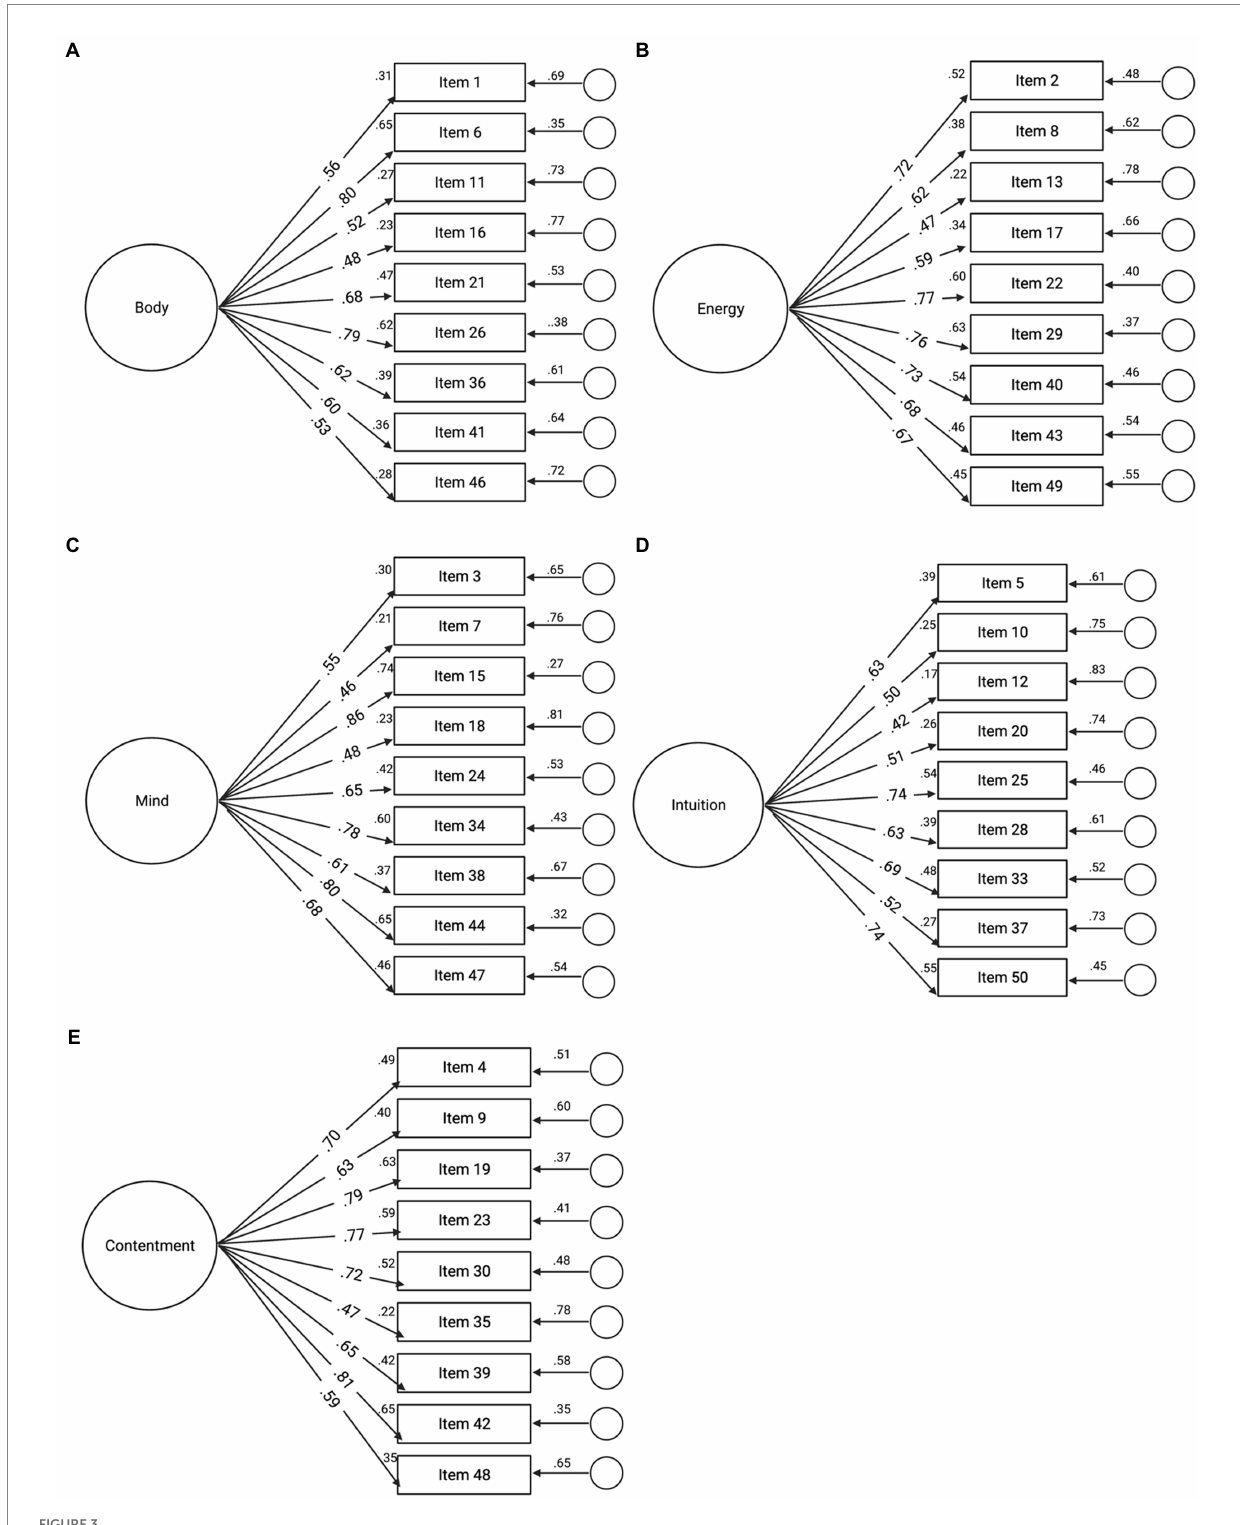
FIGURE 3 (A-E) Confirmatory factor analysis (CFA) model for five factors of MIMS. Note that items in each of the five factors are from the original 50 items. Based on confirmatory factor analysis, one item was removed from each factor. Final items can be found in Supplementary File